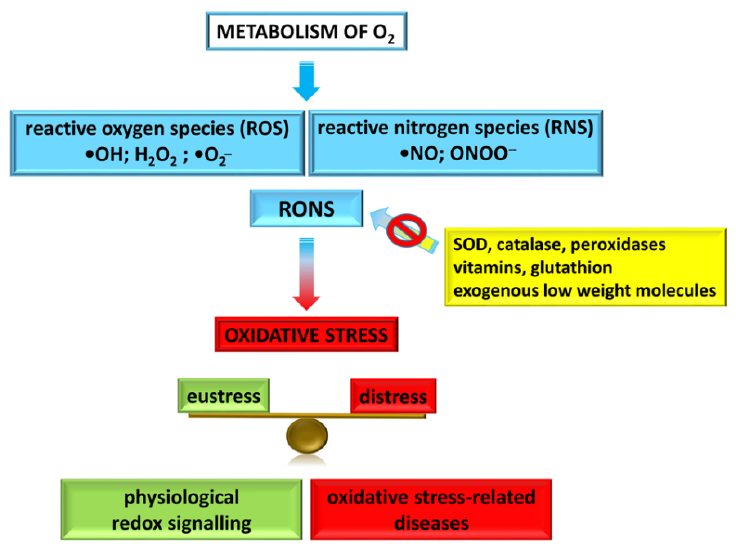
Figure 1. Schematic picture of the modern concept of oxidative